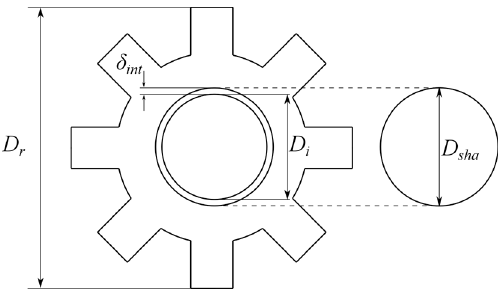
Figure 3. Interference fit main geometric dimensions.